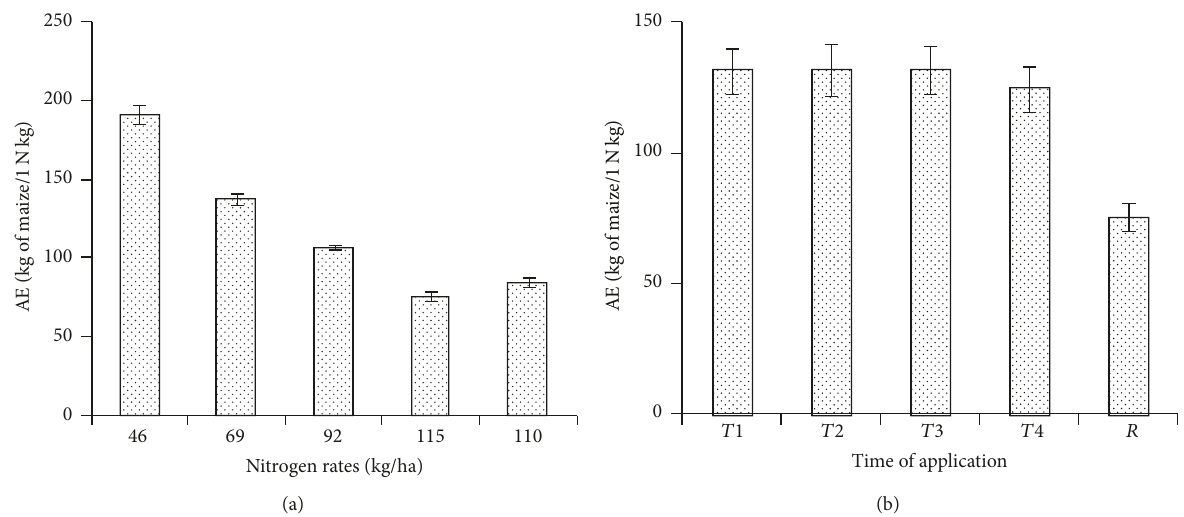
Figure 8: The effect of N rate (a) and time of application (b) on combined means of agronomic efficiency of maize. Table 2: Partial and marginal analysis as affected by N rates and time of application on maize in 2013 and 2014 cropping